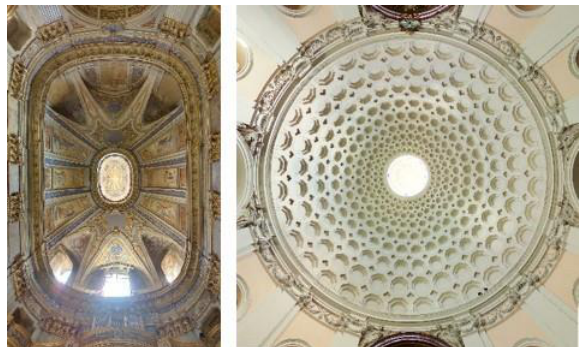
Figure 10- Zenith views of the ceiling of the churches of Santissimo Sacramento or Oratorio dell’Angelo Custode (on the left) and of San Bernardo alle Terme (on the right).